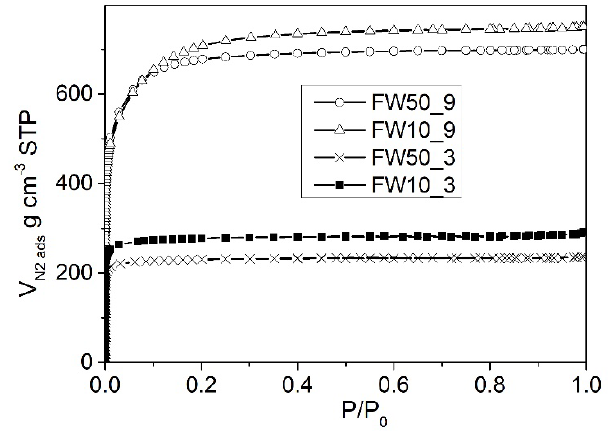
Figure 6. Nitrogen adsorption isotherms of selected carbon materials made from cellulose fibers. Table 4. Textural data of samples shown in Figure